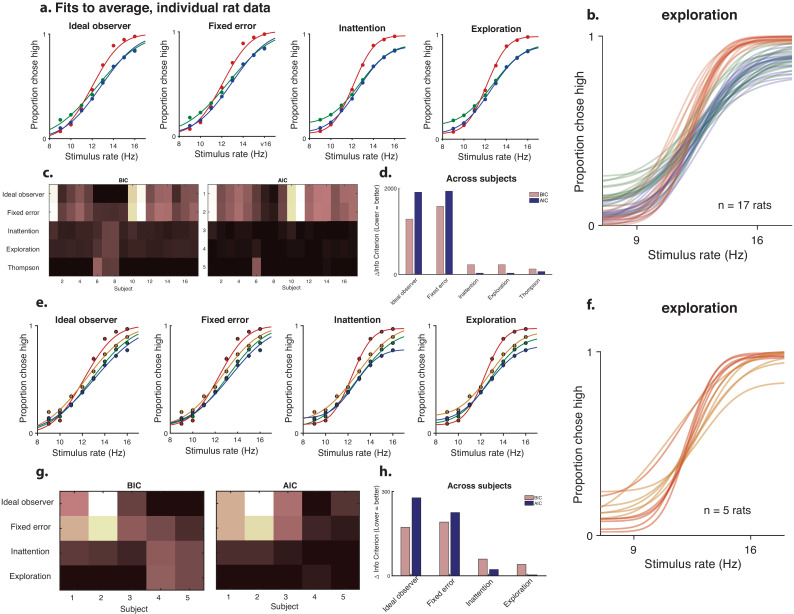
Uncertainty guided exploration outperforms competing models for average and individual data.(a) Fits of the four models (ideal observer, fixed motor error, inattention, and exploration) to average rat data on unisensory (blue – visual, green – auditory) and multisensory (red) trials. (b) Exploration model fits to unisensory and multisensory data for 17 individual animals. (c) Model comparison for individual animals using Bayes Information Criterion (BIC; left), Akaike Information Criterion (AIC; right) of the four aforementioned models, plus a constrained version of the exploration model corresponding to Thompson sampling. Darker colors are lower BICs/AICs, denoting a better fit. (d) Summed model comparison metrics across animals, showing that inattention and exploration models fit the data equally well, and much better than the ideal observer or fixed error models. Thompson sampling is preferred by BIC, since it fits as well as exploration model but with fewer effective parameters. (e) Fits of the four models to average data including neutral trials (orange) provide a stronger test of the inattention model. (f) Exploration model fits to multisensory data including neutral trials for five individual animals. (g) Model comparison for individual animals. (h) Summed model comparison metrics across animals shows that the uncertainty-guided exploration model performs better than other models.